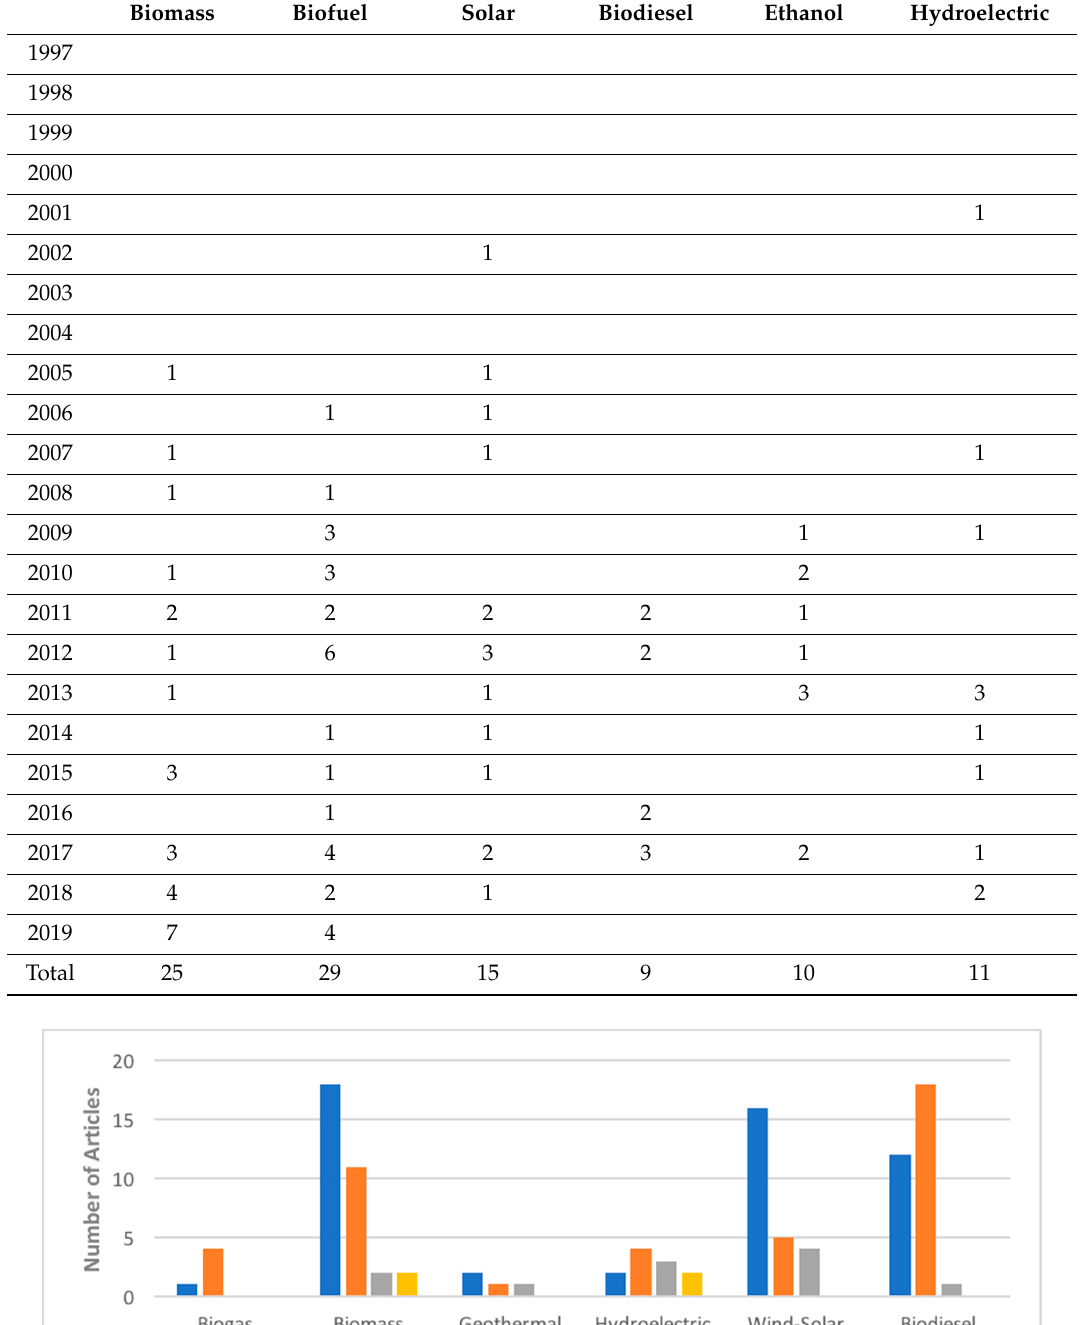
Table 2. Main renewable energies focused on in the sample articles. Biomass Biofuel Solar Biodiesel Ethanol Hydroelectric